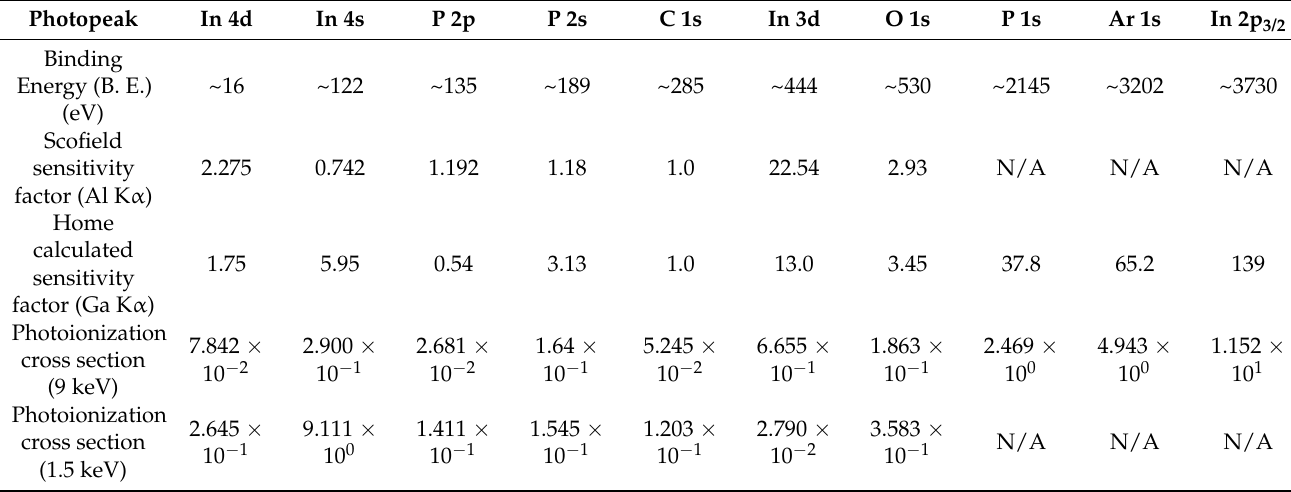
Table 1. Sensitivity factors (Scofield factors for Al-K α , home calculated for Ga-K α ) and photoionization cross sections concerning the photopeaks of